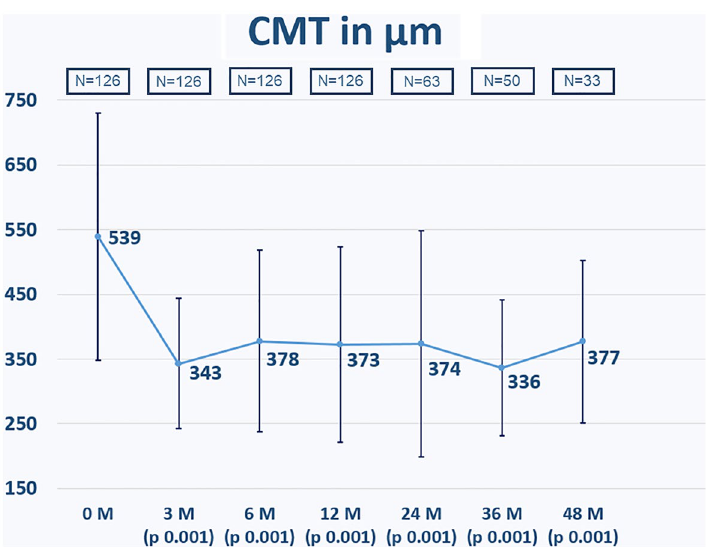
Figure 4. The change in central macular thickness (CMT, µm) during the study observation period. p values refer to statistical differences between each time points and baseline: CMT decreased significantly at all time points (p =